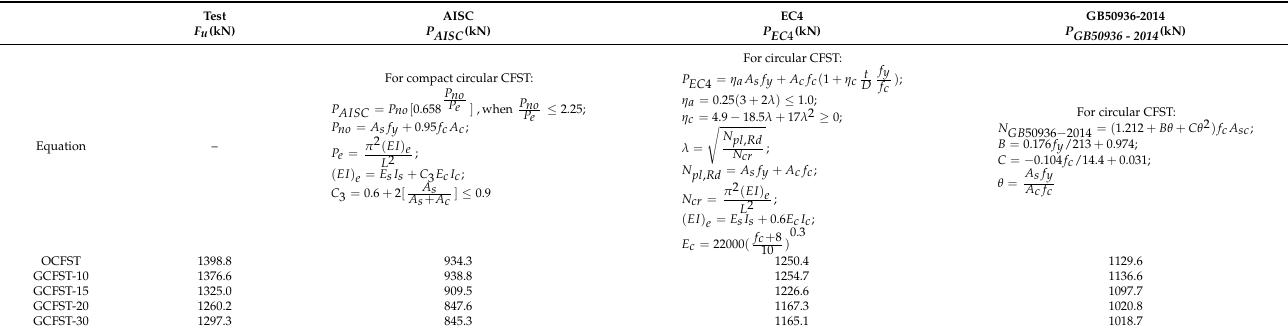
Table 4. Comparison of test results and code predictions.